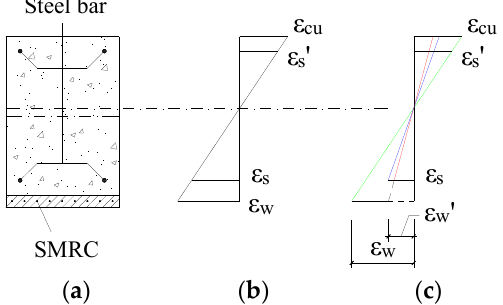
Figure 20. Mechanism analysis: ( a ) cross-section, ( b ) strain distribution without sustaining load, ( c ) strain distribution under sustaining load.